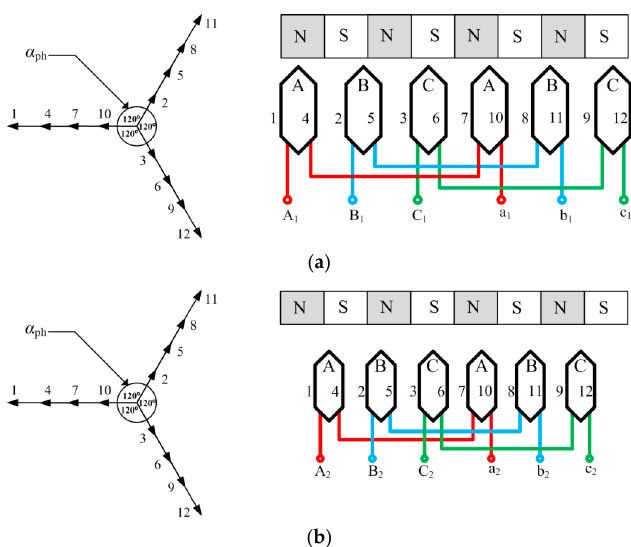
Figure 8. Star of slots and winding connections: ( a ) Outer stator machine; ( b ) Inner stator machine.